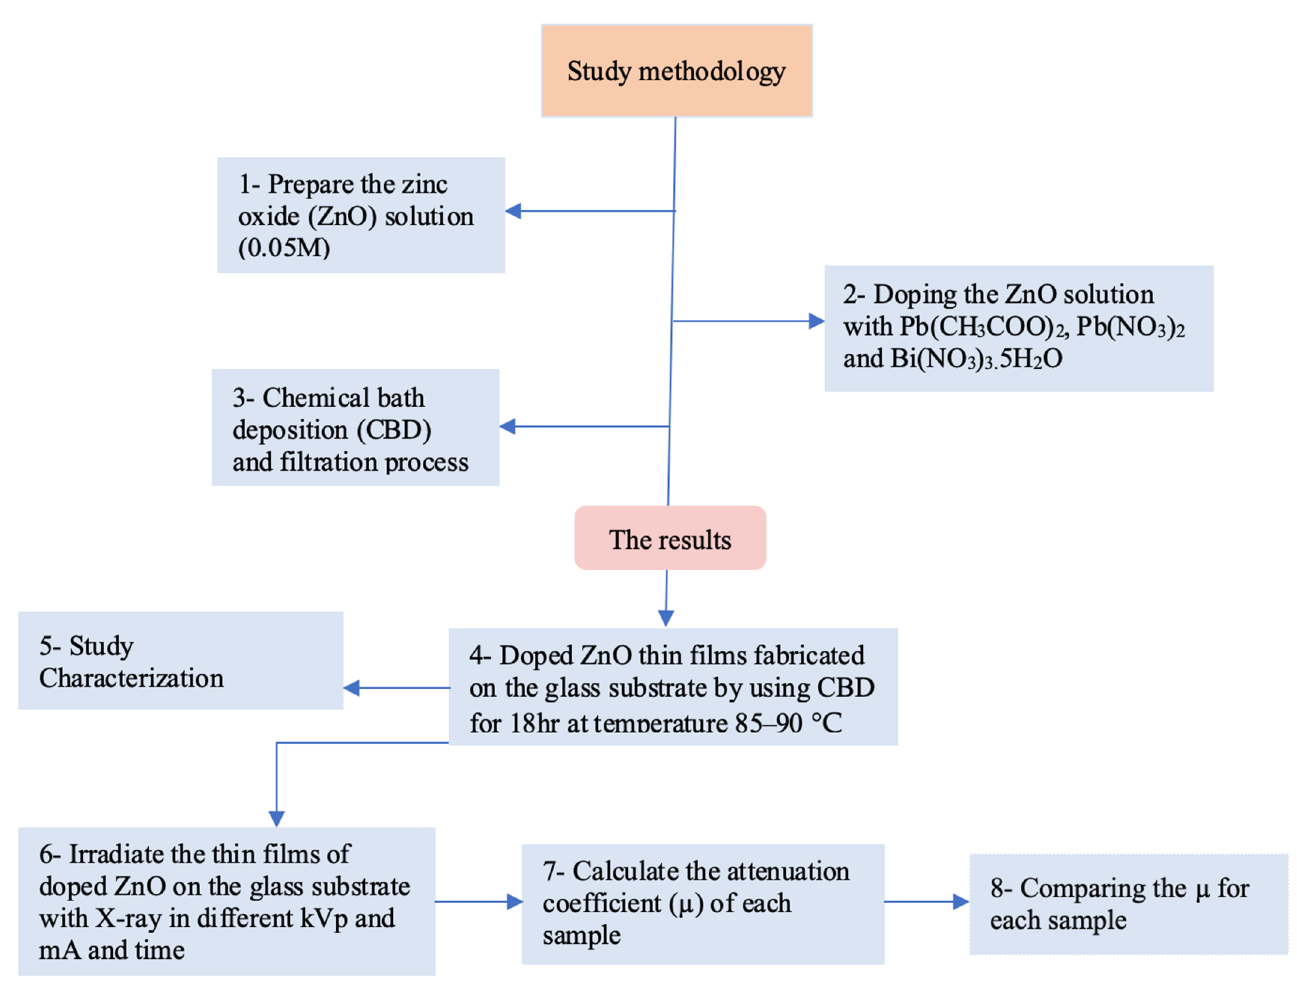
Figure 2. Flowchart of study methodology. Table 1. Weight% of doping agents (LA, LN, and BN) mixed in ZnO solution. Doping (wt.%) Mass of Each Dopant (g)